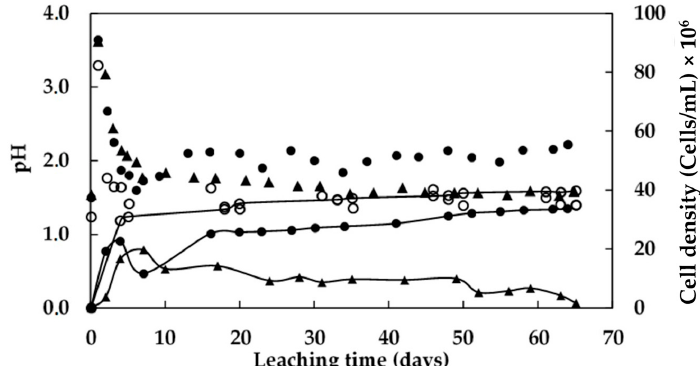
Figure 14. Variation in pH in bioleaching solution during copper extraction from chalcopyrite at ambient temperature with different raffinate solutions. The evolution of cell density is also shown (dashed line). ▲ 3.0 g/L of acid and 10 6 cells/mL, continuous irrigation; ● pH-controlled at 1.5 and irrigation cycle.